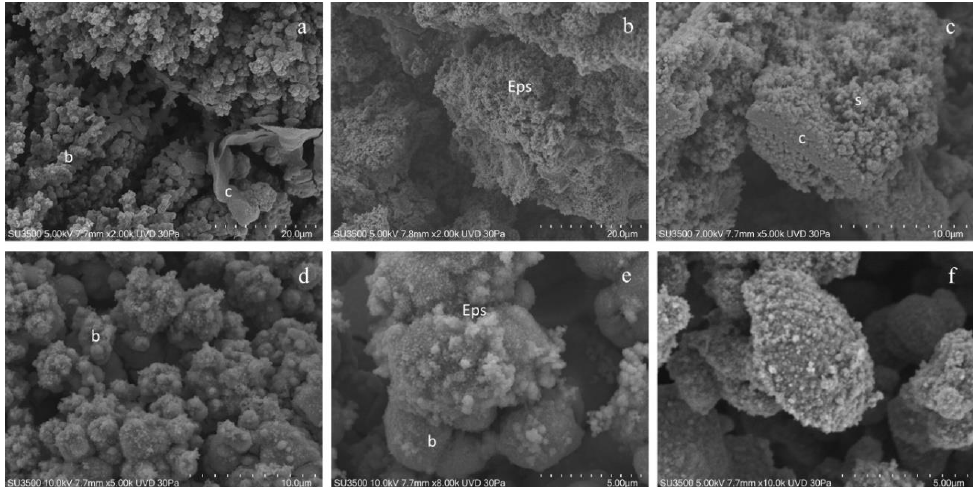
Figure 2. S. mutans prepared by conventional VP-SEM procedure. ( a ) VP-SEM 2000X. Biofilm bacterial towers b forming an intricate micro-canalicular system, and sheet of compact matrix c are shown. ( b ) VP-SEM 2000×. Spongy biofilm matrix with the Eps showing no sign of collapse or shrinking; it is well preserved in its hydrated state. ( c ) VP-SEM 5000×. Spongy Eps, s, i s developing from a layer of the compact Eps, c. ( d ) VP-SEM 5000×. Bacterial towers b, superficial granulation represents the Eps secretion. ( e) VP-SEM 8000×. On S. mutans ’ cells surface, b is clearly visible in the fine graininess of